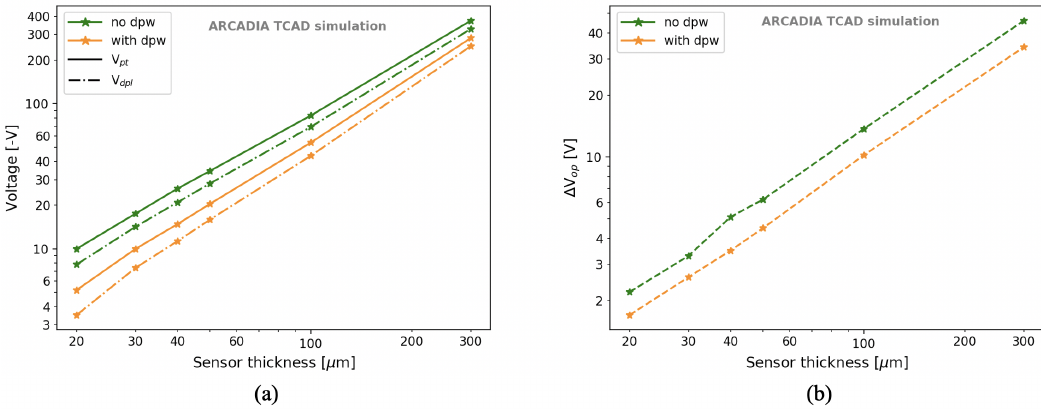
Figure 19. Dependence of V dpl and V pt ( a ) and of the operating voltage range ∆ V op ( b ) on the sensor thickness.